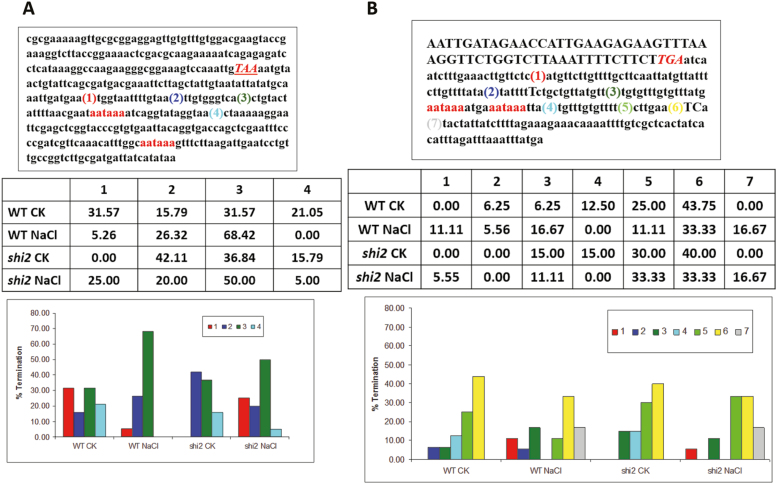
The polyadenylation site selection is altered in the shi2 mutant. (A) Polyadenylation sites of the LUC transgene determined by using 3' RACE. Four detected polyadenylation sites and the ratio of polyadenylation at each site are shown. (B) Polyadenylation sites of the native SOT12 gene determined by using 3' RACE. Seven detected polyadenylation sites and the ratio of polyadenylation at each site are shown. CK, control without salt treatment; NaCl, 200 mM NaCl treatment for 5 h. (This figure is available in color at JXB online.)